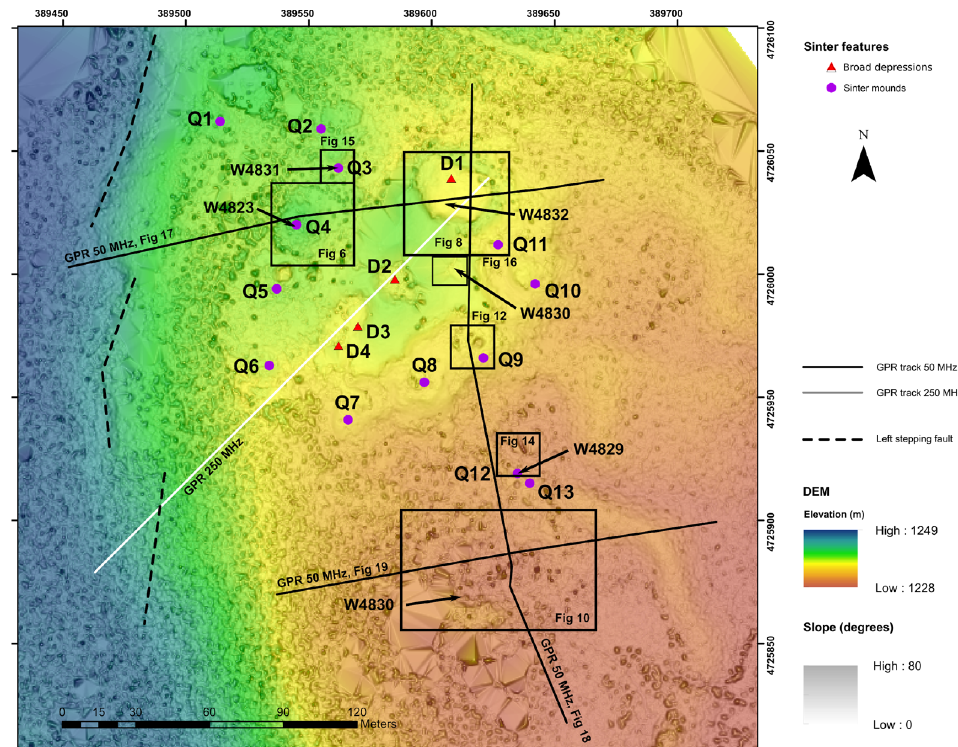
Figure 5. Sinter mounds (purple O) and broad shallow depressions (red triangle). The more southern of these features (Q7, Q8, Q10) have asymmetric aprons that dip south with topography. GPR track from December, 2013 [4] shown in white, and tracks from May, 2014 (current study) are shown as a solid black line. Surface morphology and the elevation model suggest a left-stepping fault striking N ‐ NE (dashed line). Table 1. Descriptions and elevations of broad depressions (e.g., D1) and sinter mounds (e.g., Q1) at Mickey Springs.